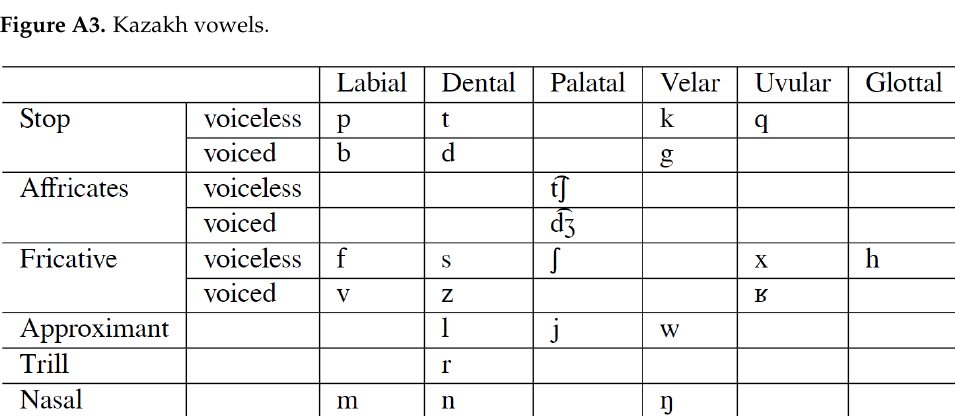
Figure A4. Kazakh consonants.